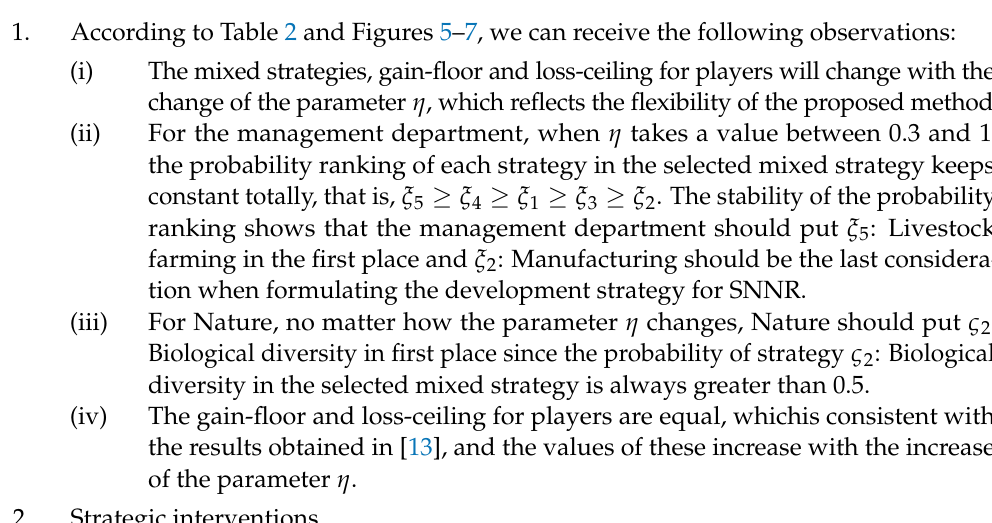
Figure 7. Gain-floor U ∗ and loss-ceiling V ∗ with parameter η varying from 0 to 1.